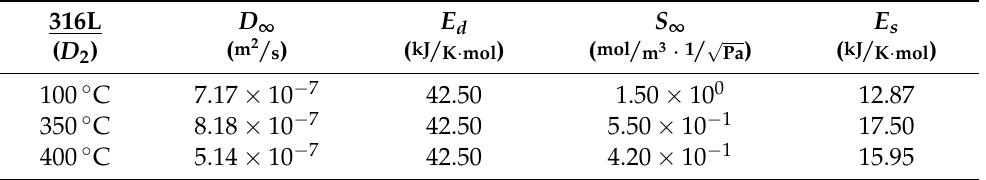
Table 2. Dissolution parameter estimates from applying the curve-matching procedure to the experiments presented in this